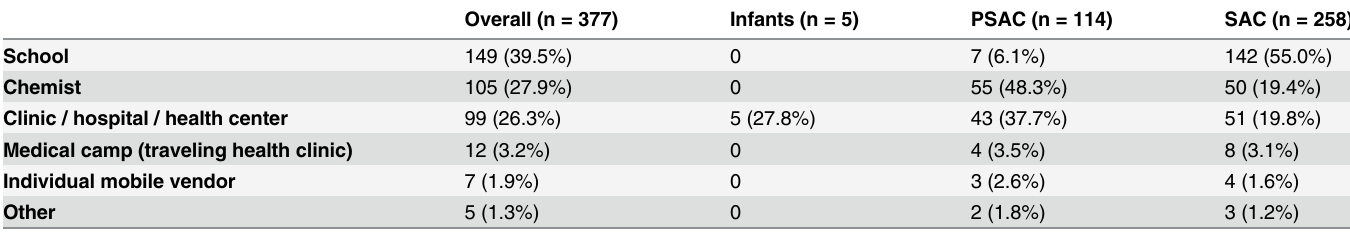
Table 1. Sources of drugs for the most recent deworming, overall and by child type, among children who were reported as taking deworming medications at least once during the past year, Kibera, Kenya,